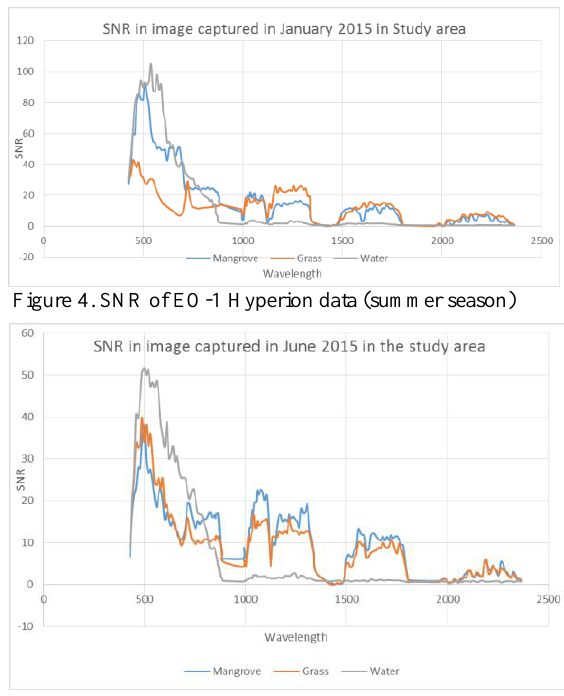
Figure 5. SNR of EO-1 Hyperion data (winter season) The estimated SNR for both season are in good agreement with the predicted SNR for EO-1 Hyperion (Pearlman, 2003). The